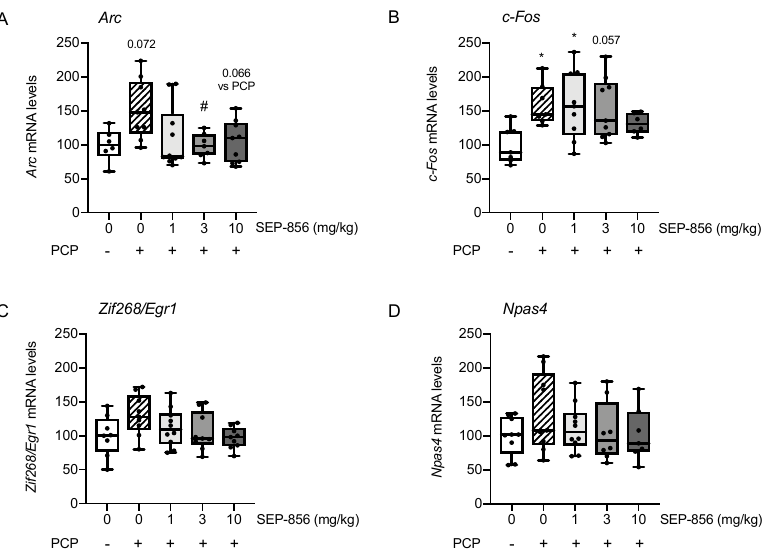
Figure 3. Modulatory activity of acute SEP-856 treatment on IEG changes after acute PCP admin- istration. The mRNA levels of Arc ( A ), c-Fos ( B ), Zif268/Egr1 ( C ) and Npas4 ( D ) were measured in the prefrontal cortex of rats pretreated with vehicle or SEP-856 (1, 3 or 10 mg/kg) following the acute injection of PCP (2 mg/kg). The data, expressed as percentage of vehicle-treated rats set at 100%, are represented as box-and-whisker plots of at least six independent determinations. For each box, the box boundaries indicate the first and third quartiles, the middle line specifies the median and the whiskers represent the lowest and highest values. * p < 0.05 vs vehicle-treated rats; # p < 0.05 vs PCP-treated rats (one-way ANOVA followed by Tukey post-hoc comparison).